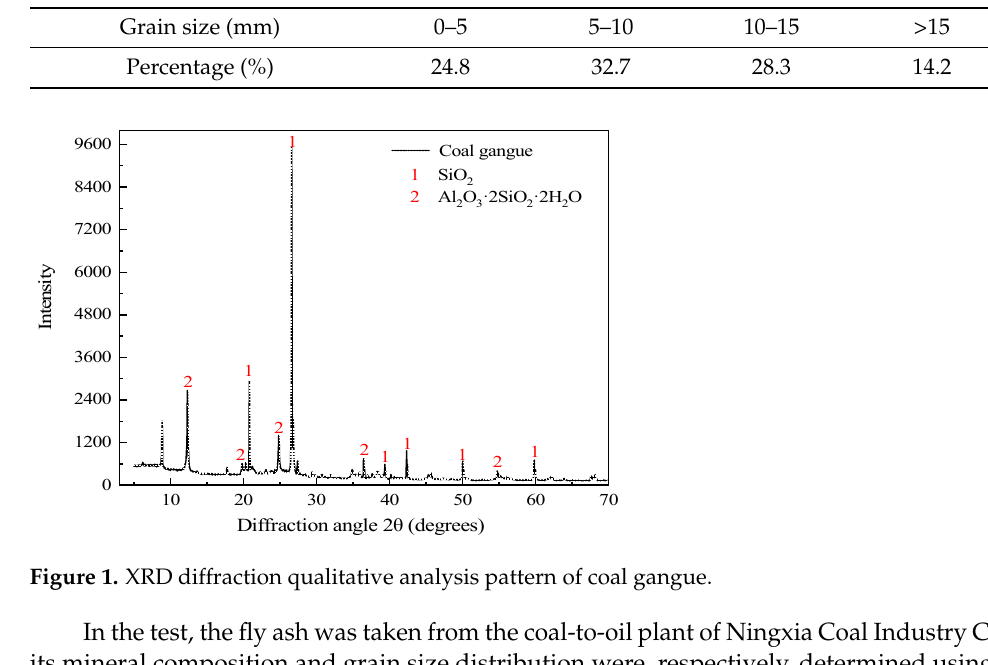
Table 1. Gangue size classification.